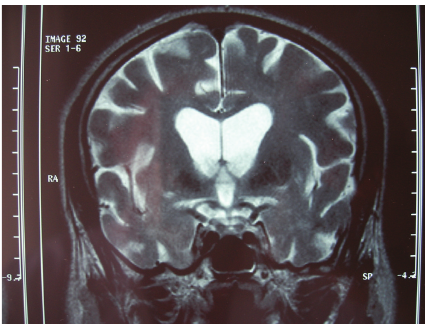
Figure 4: Bilateral calcifications in the basal ganglia and white matter signal changes on